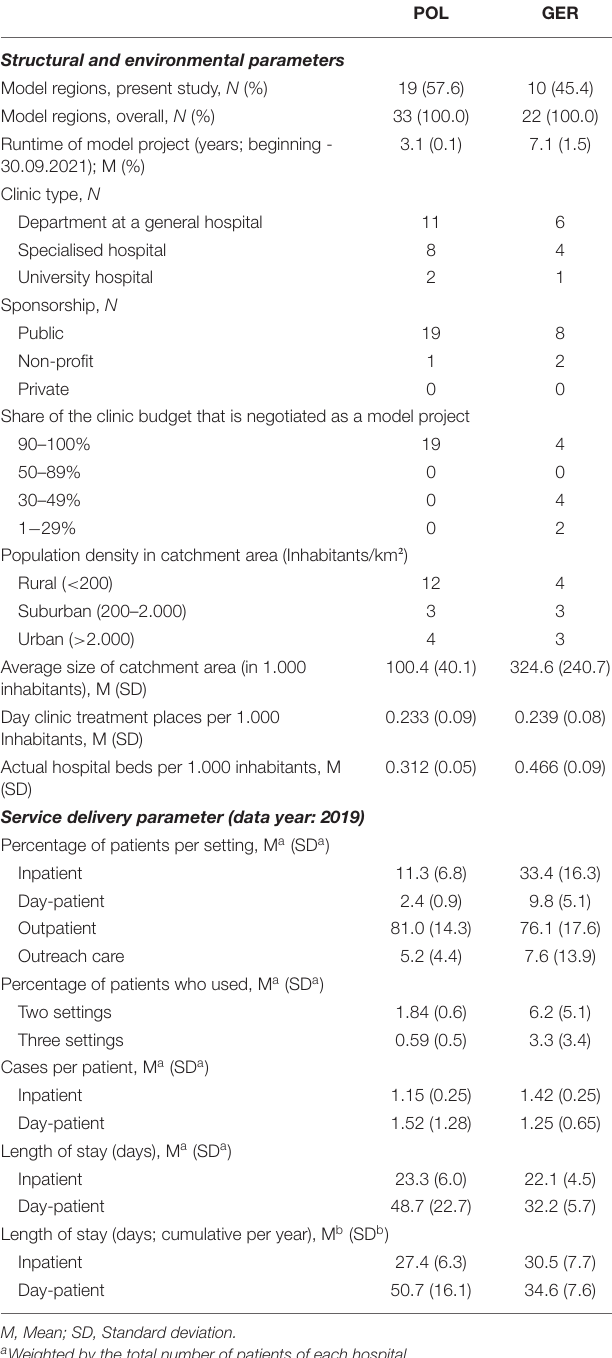
TABLE 3 | Structural and statistical parameters of service delivery in FIT models in Poland (“POL”) and Germany